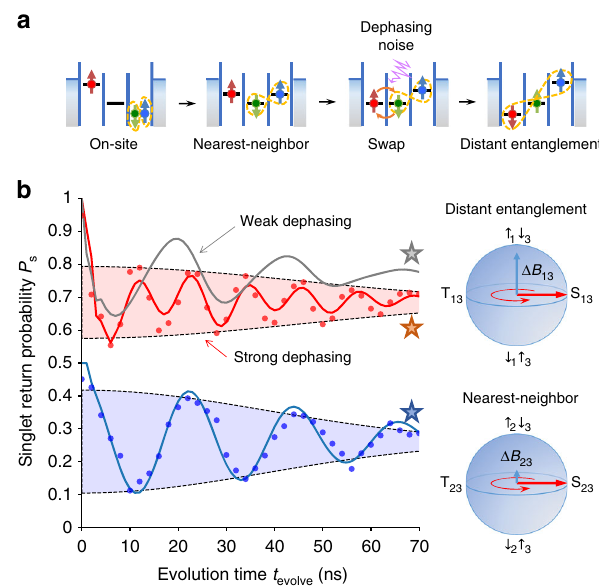
Fig. 3 Coherent transfer of spin entanglement. a Illustration of the entanglement transfer process. Local spin entanglement is prepared in QD3 and then split to the nearest neighbors (QD2, QD3), followed by the noise- assisted transfer to distant sites (QD1, QD3). b Coherent evolutions of the distant entanglement (taken at ε / h = − 44 GHz, red circles) and the nearest-neighbor entanglement ( ε / h = − 7 GHz, blue circles offset for clarity). The simulation data are scaled to take into account the readout error in the data (Methods section). The singlet-return probability P S inferred from the single-shot spin blockade measurement is plotted as a function of t evolve . The data points are obtained by performing a Gaussian convolution fi lter of the width σ ε = 0.9 GHz for the detuning. Solid lines show the numerical calculations of the coherent evolutions at ε / h = − 44 GHz (red and gray) and ε / h = − 7 GHz (blue) with the dephasing rates γ ¼ 1 : 7 GHz , γ ¼ 0 : 12 GHz and γ = γ ¼ 100 (red and blue) and with t t ε t L R L ; R L ; R ¼ 17 MHz and γ ¼ 1 : 2 MHz (gray). The simulation the smaller rates of γ t t L R results are reproduced from Fig. 4c by choosing corresponding detuning values marked by stars. The envelopes of the oscillations correspond to a (cid:6) 60 ns for both cases due to the Overhauser fi eld Gaussian decay with T (cid:7) 2 fl uctuation 5 during the ensemble averaging time of 22.7 s. This phase averaging effect is independent of the Markovian dephasing noise which is dominant only around ε = ε L,R as discussed